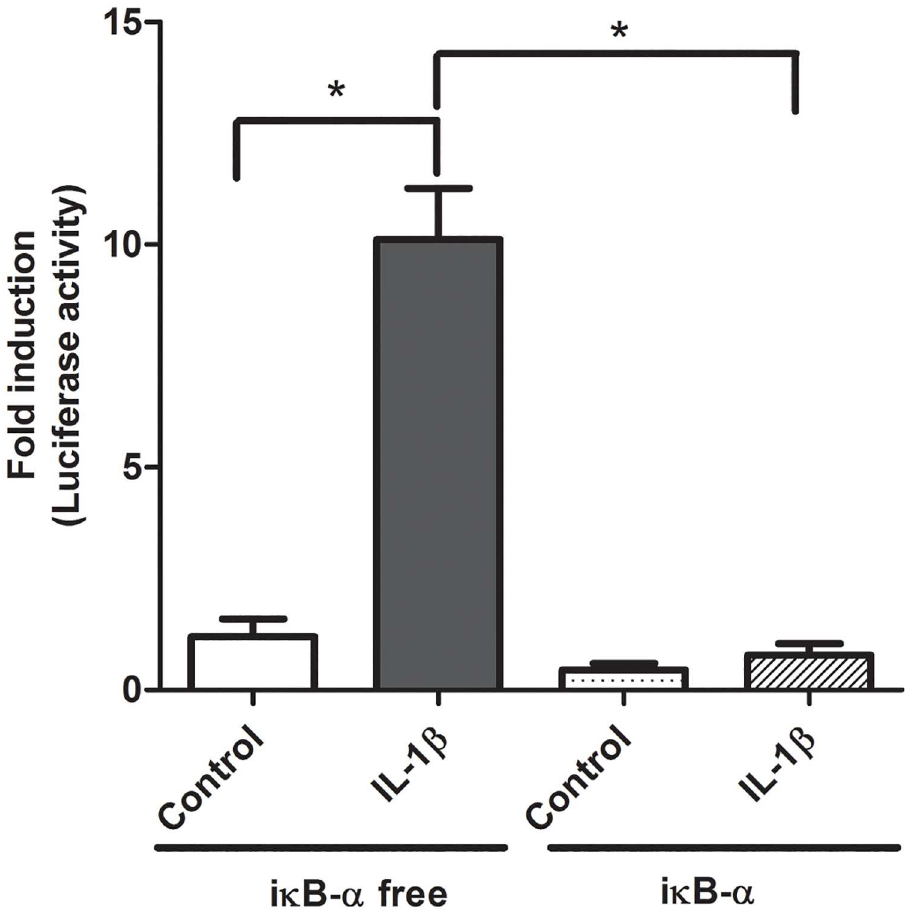
Fig 1. Effects of i κ B- α and IL-1 β -inducible NF- κ Bactivation. Caco-2 cells were transfected with pNF- κ B-Luc for 18 hours, then treated ± IL-1 β (4 ng/ml) for 4 hours. Cell lysates were assayed for luciferase activity and protein concentration as describedin Methods . Data are expressedas fold inductionof normalized luciferase activity ± SE. * P < 0.05 (n = 6 /group).